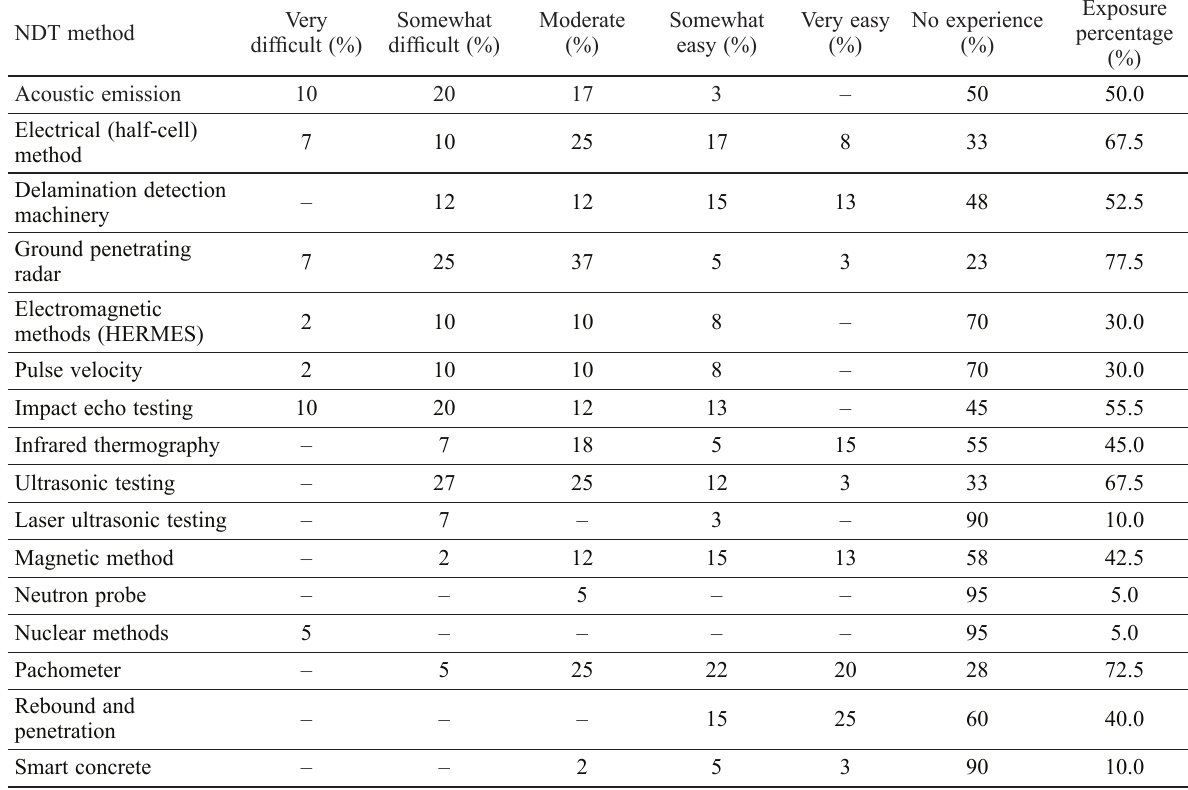
Table 6. Concrete NDT methods: degree of